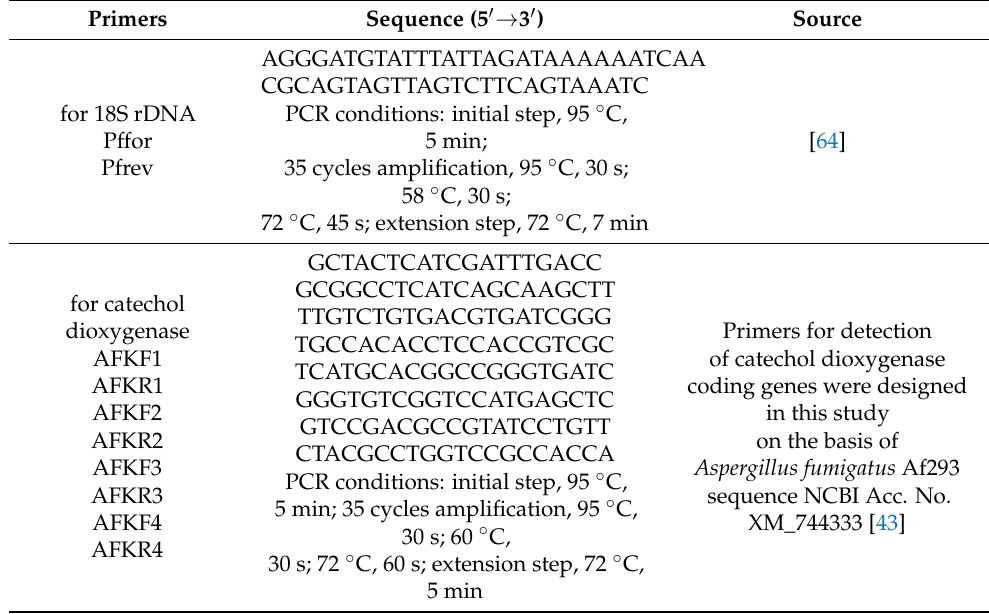
Table 1. The list of the used oligonucleotide